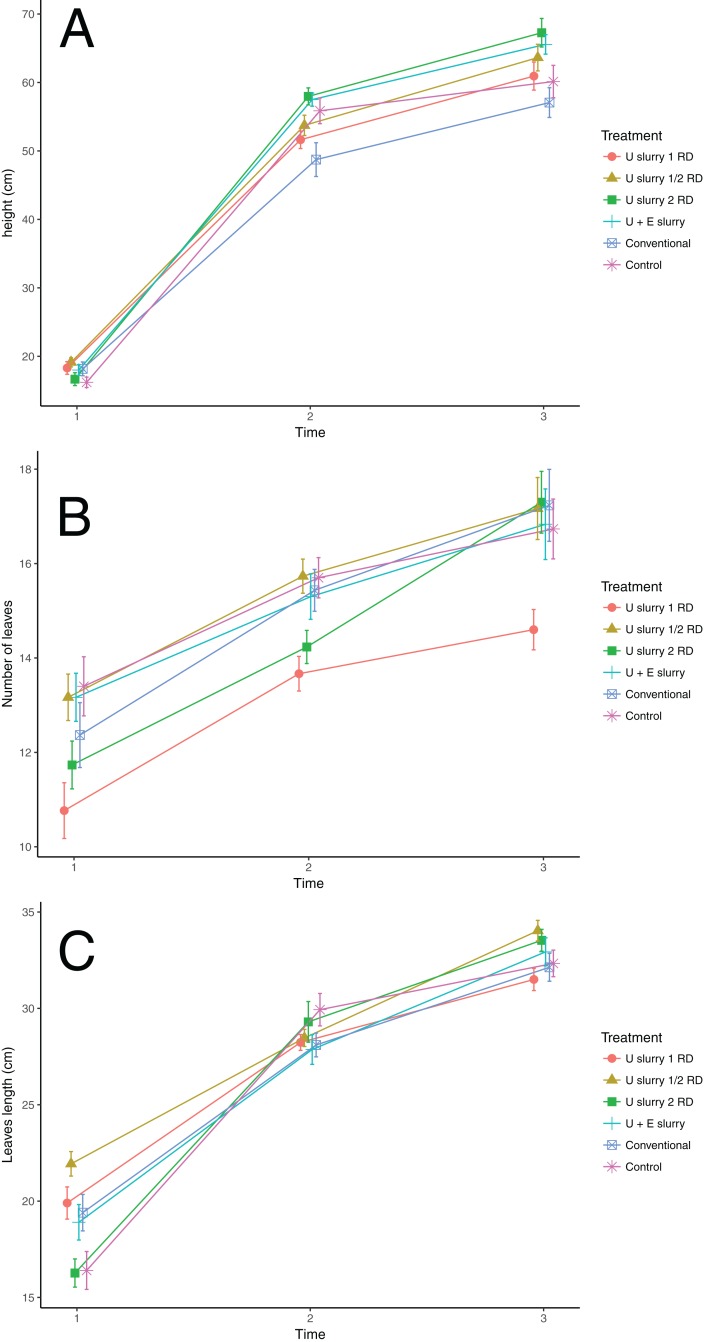
Effect of treatments on the plant size variables at times 1, 2, and 3.(A) Height; (B) Number of leaves; (C) Leaves length; Colors and symbols represent treatments. Dates (m/d) of each time were T1: 4/14; T2: 5/3; T3: 6/1. Treatments are noted as U slurry 1 RD: recommended Urtica dose; U slurry 1/2 RD: half the recommended dose; U slurry 2 RD: double the recommended dose; U + E slurry: Urtica recommended dose in combination with Equisetum; Conventional: conventional foliar manure; control.